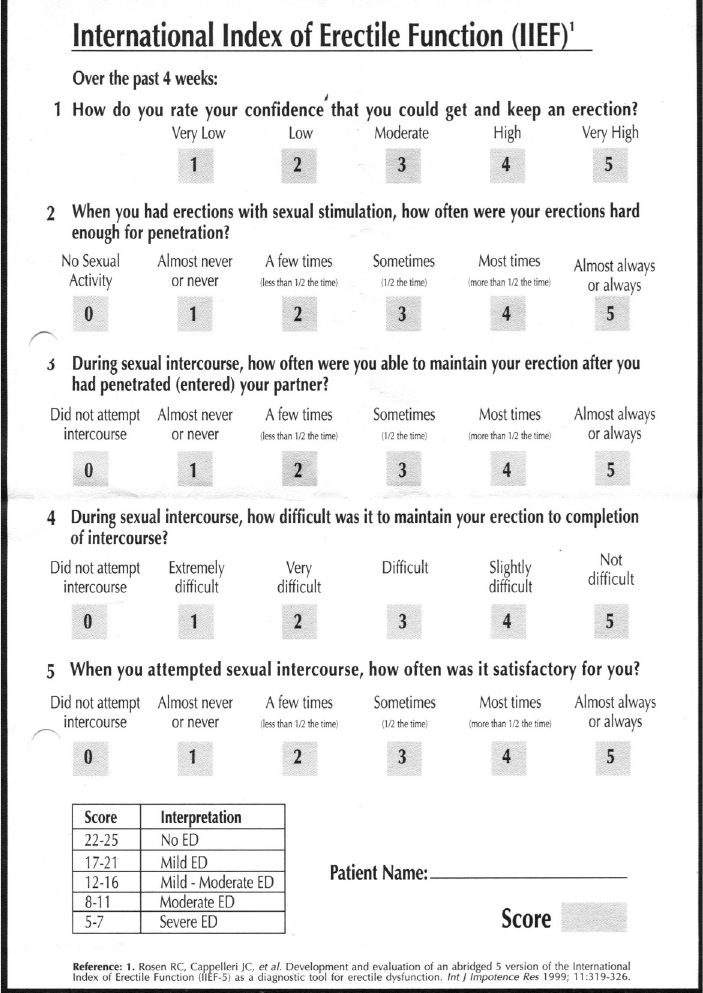
Fig. 1. International Index of Erectile Function.